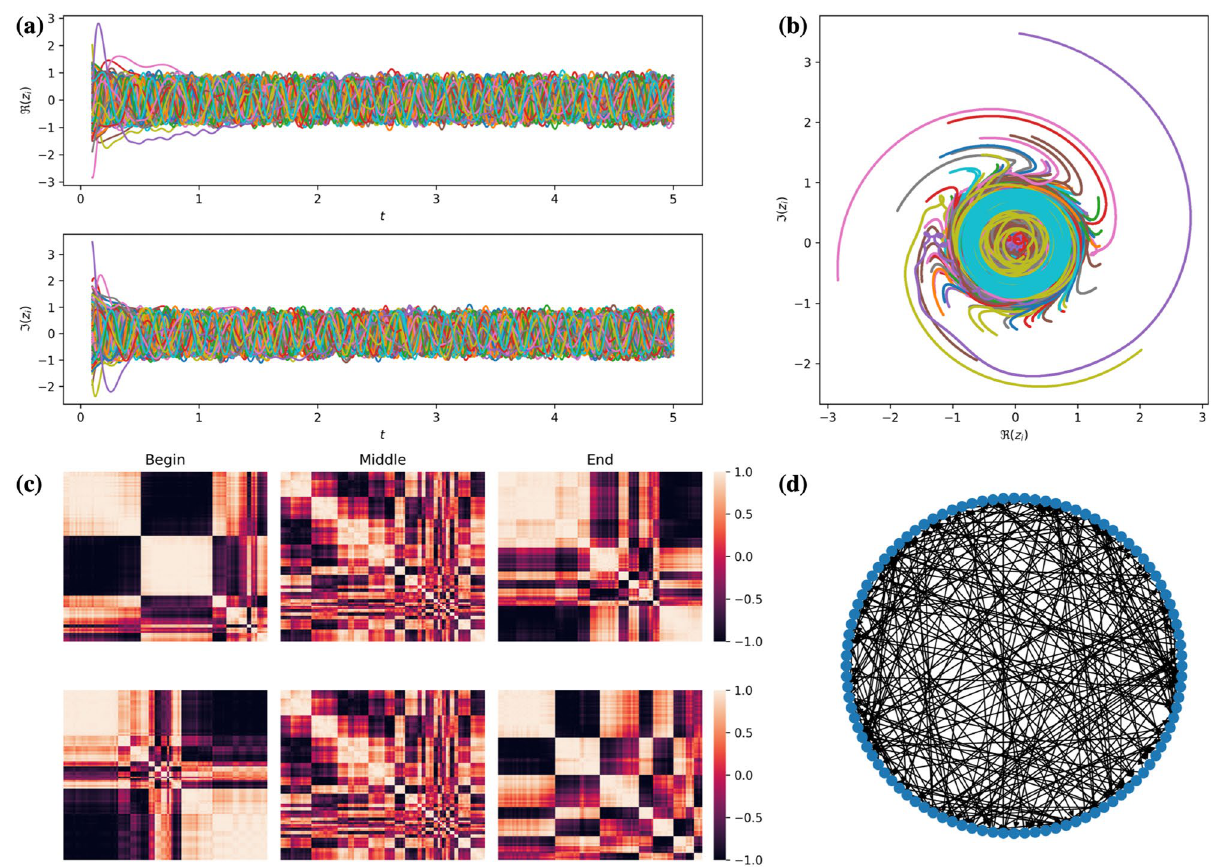
100 spin-torque oscillators with coupling parameters Figure 2. The collective behavior of the network of N = 0.075 and β 0.01 in the absence of external input. The adjacency matrix A is randomly filled with α = = ones with probability 1/40. (a) Time series of the real (top panel) and imaginary (bottom panel) parts of z i , V . (b) Phase portrait of (3). (c) Correlation matrices for the time-series of real (top panel) and imaginary i ∈ V over the time interval of length � T 1 / 12 ns taken at the beginning (left (bottom panel) parts of z i , i ∈ = figures), middle (middle figures), and at the end (right figures) of simulation. Please see section Methods for the description of the clusterization method used for correlation matrices. (d) Graphical representation of the graph G